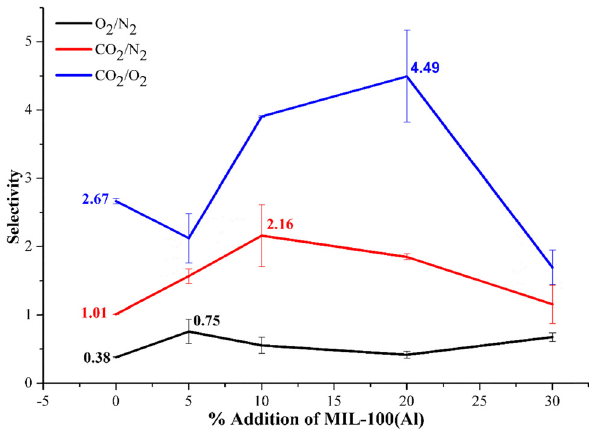
Figure 14: Gas selectivity graph of CO 2 /O 2 , CO 2 /N 2, and O 2 /N 2 for di ff erent percentage additions of MIL - 100 ( Al ) to PES.